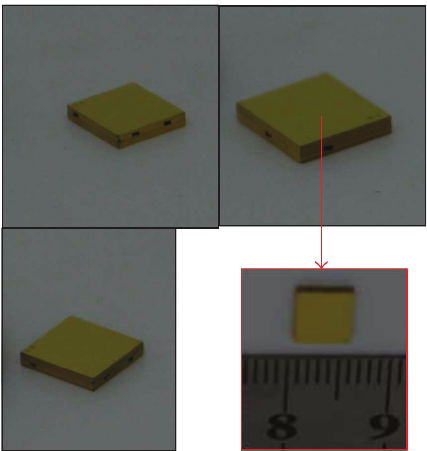
Figure 8: Photographs of testing topologies fabricated using DRIE on silicon wafers, with inner and outer surface metallization.